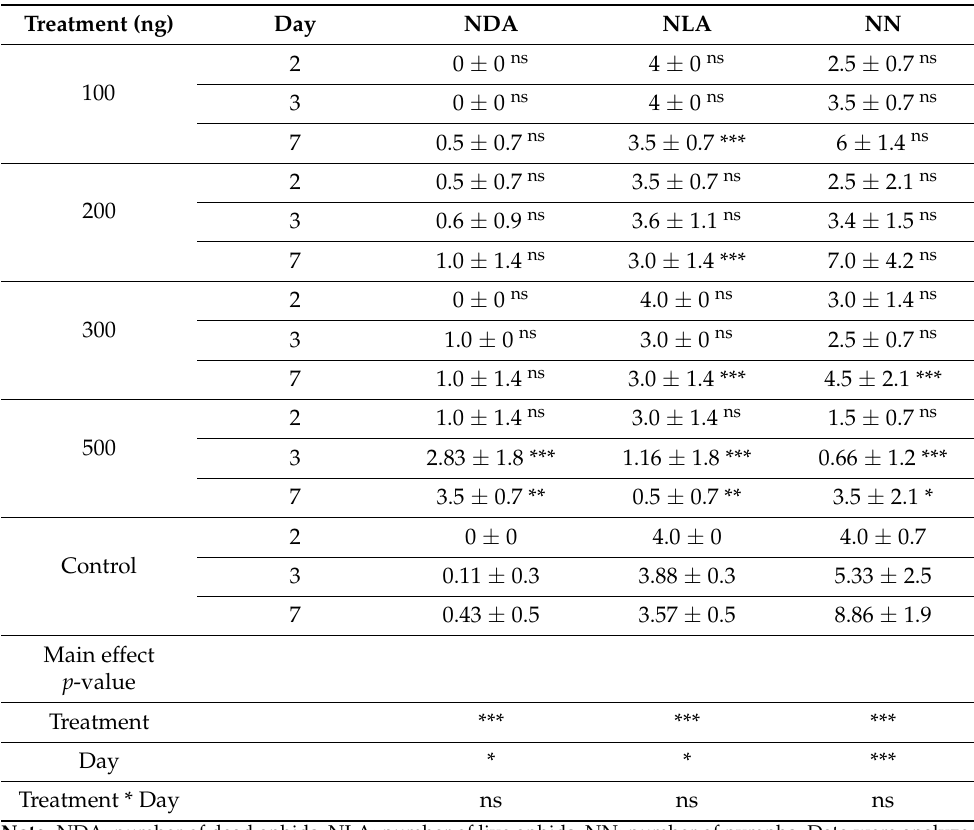
Table 2. Effect of varying concentrations of dsRNA- AChE on banana aphid mortality, survival, and